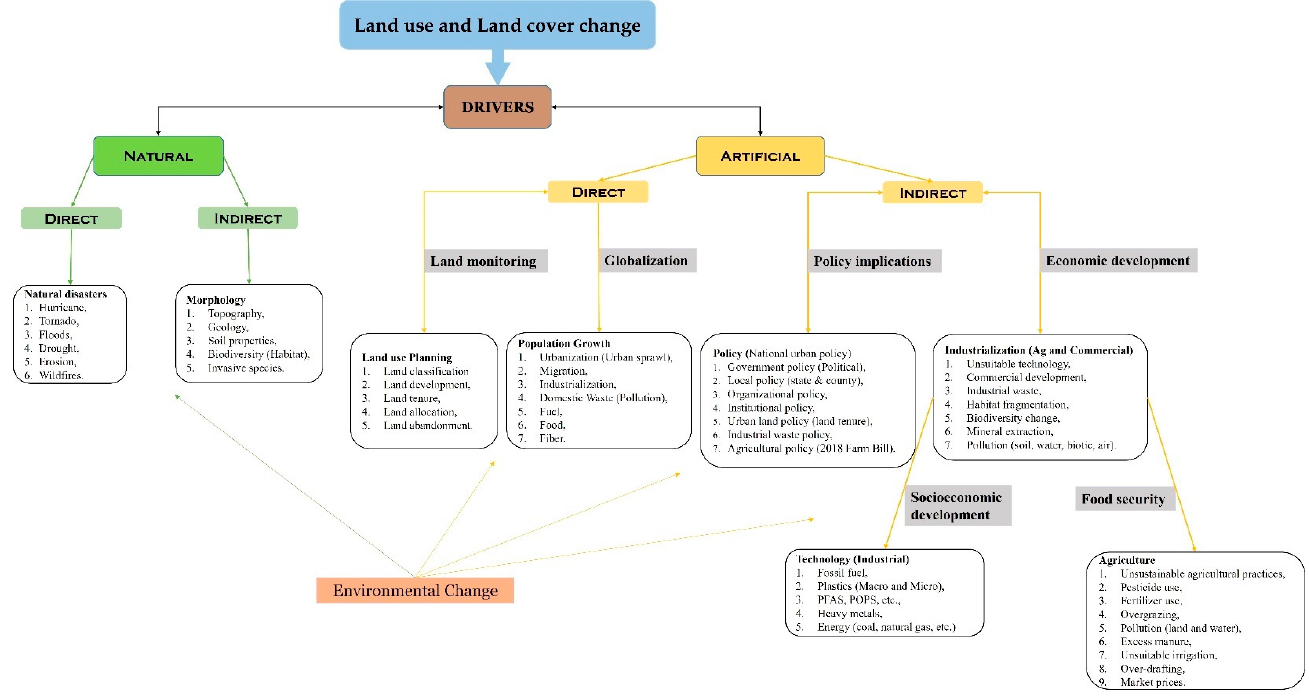
Figure 3. Illustration of drivers associated with LULCC in the SEUS.